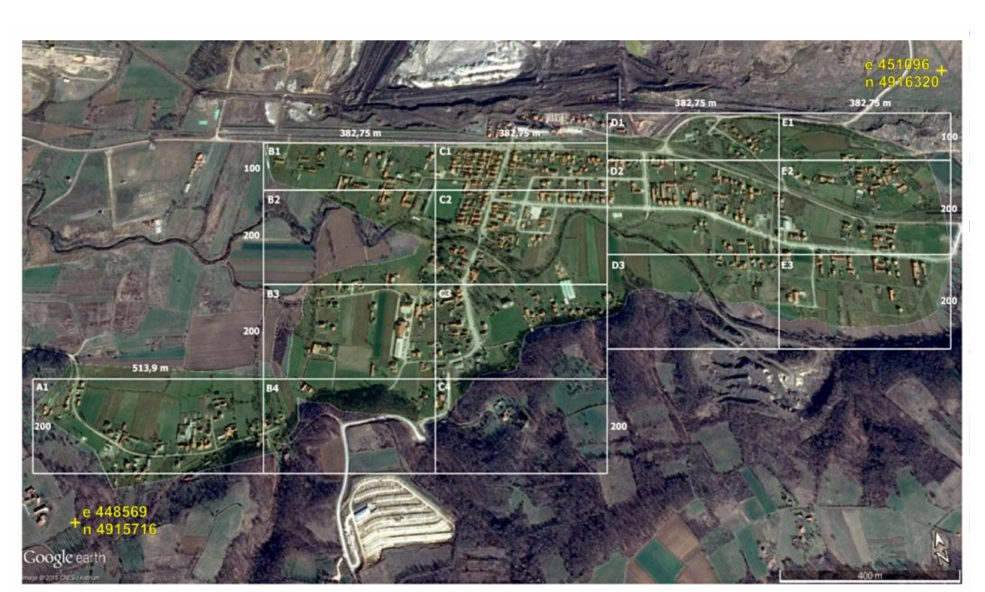
Figure 2. Produce sampling map of Baroševac